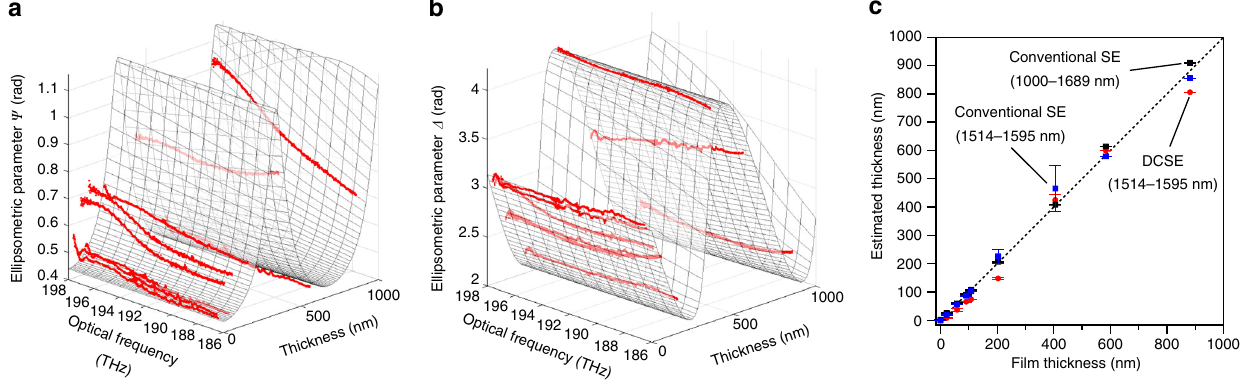
Fig. 4 Ellipsometric evaluations of thin- fi lm samples using the DCSE system. The ellipsometric parameters, a Ψ and b Δ , obtained using the DCSE system ( red dots ) and through theoretical estimation ( mesh surfaces ). c Thicknesses determined via DCSE with the spectral range of 1514 – 1595 nm ( red ) and via conventional SE with the spectral range of 1000 – 1689 nm ( black ) or 1514 – 1595 nm ( blue ). Error bars indicate the standard